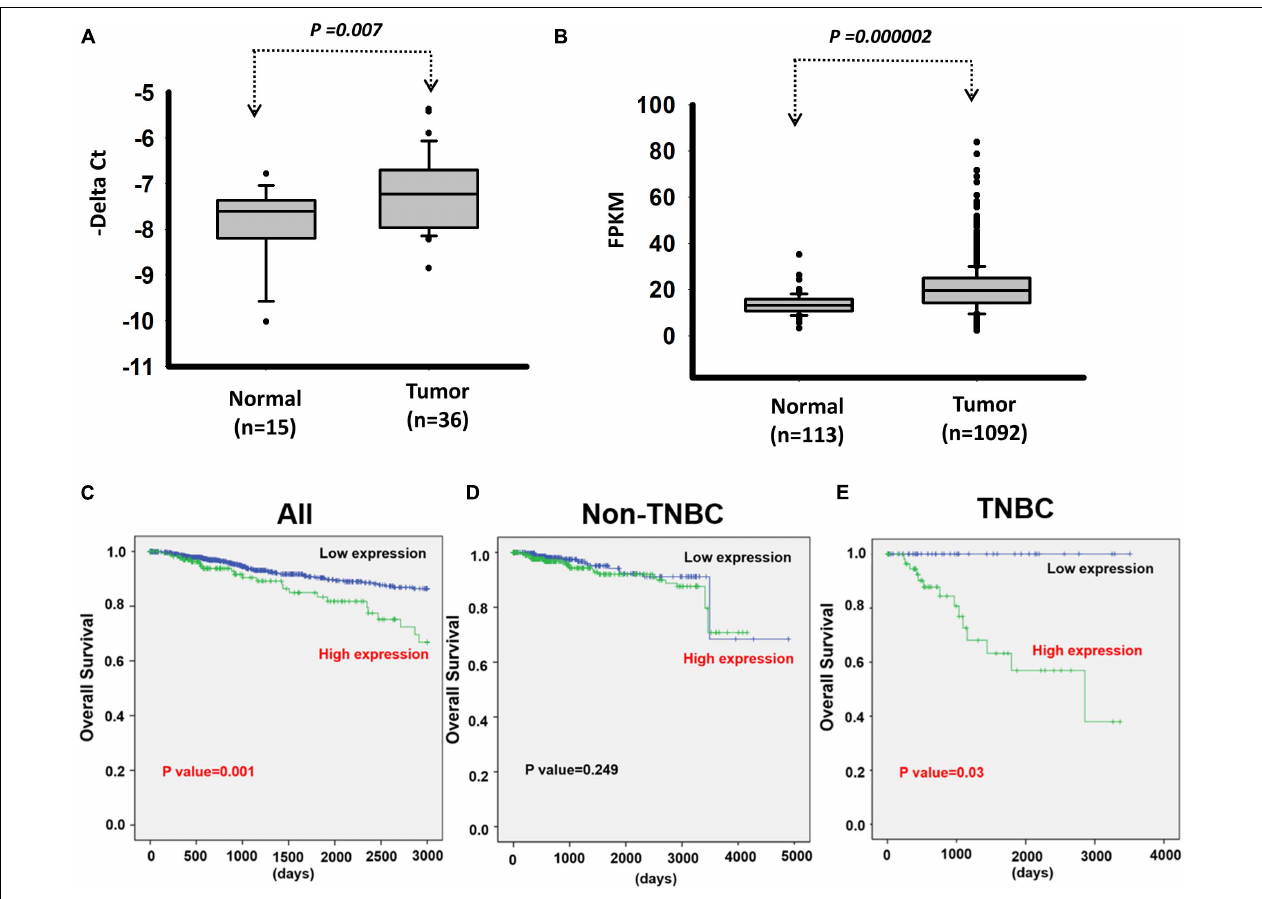
FIGURE 3 | Analysis of LOC550643 expression levels in breast cancer tissues. (A) Expression levels of LOC550643 in breast cancer tissues and corresponding adjacent normal tissues (real-time PCR). (B) Expression levels of LOC550643 in human breast cancer tissues versus normal tissues (TCGA database). (C–E) Impacts of LOC550643 expression on the OS of TNBC patients versus non-TNBC